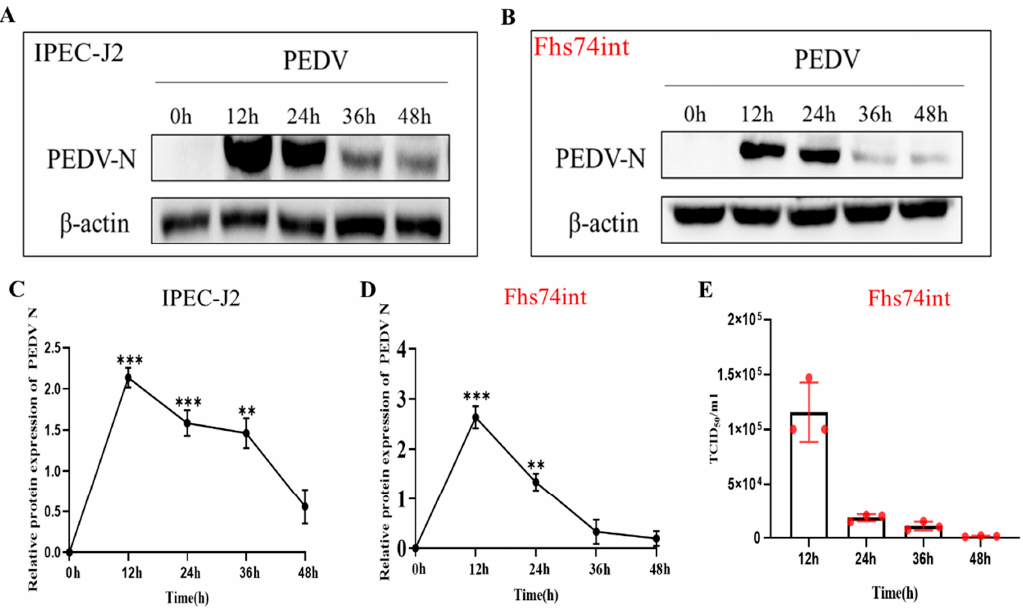
Figure 6. Expression levels of M genes at different time points in PEDV-infected IPEC-J2 cells and FHs 74 Int cells. ( A ) Amplification of the PEDV M gene product using fluorescent primers. ( B ) Absolute quantitative standard curve of PEDV M gene expression. ( C ) Expression of the M gene in PEDV-infected FHs 74 Int cells. ( D ) Expression of the M gene in PEDV-infected IPEC-J2 cells. ( E ) Changes of viral titer after infection with FHS 74 Int cells 12, 24, 36 and 48 by the PEDV-LJX strain. (** p -value < 0.01; *** p -value < 0.001).